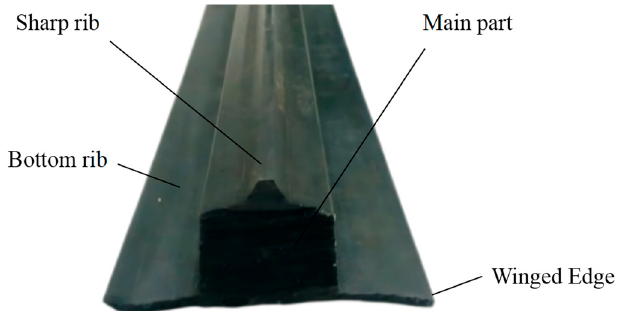
Figure 3. The traditional GINA gasket (redrawn according to Xiao et al. [10]).